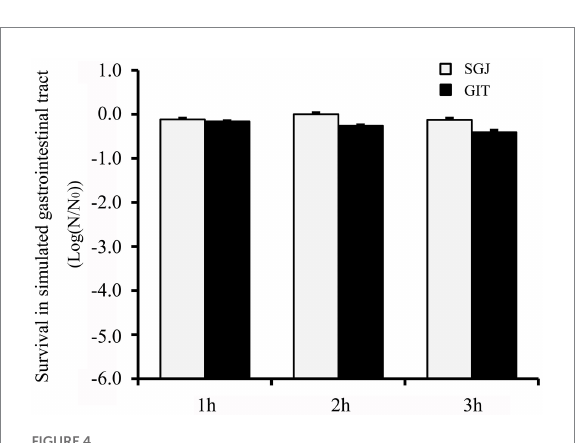
FIGURE 4 Tolerance of simulated gastrointestinal tract (GIT) transit of the cells of Lactobacillus plantarum GXL94. Survival was expressed as reduction of log (N/N0) cycles, where N 0 and N are the number of viable cells, respectively, before and after exposure to stress; standard error bars are